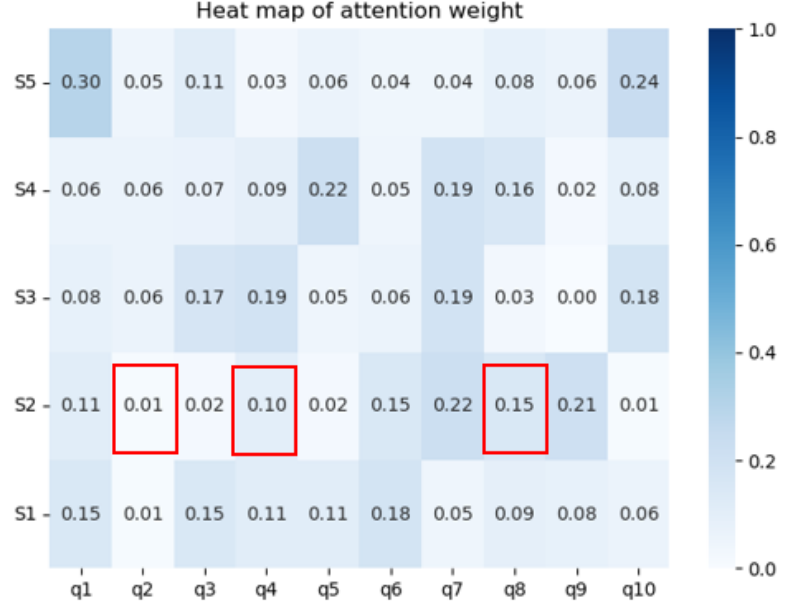
Figure 6. Initial attention weights.